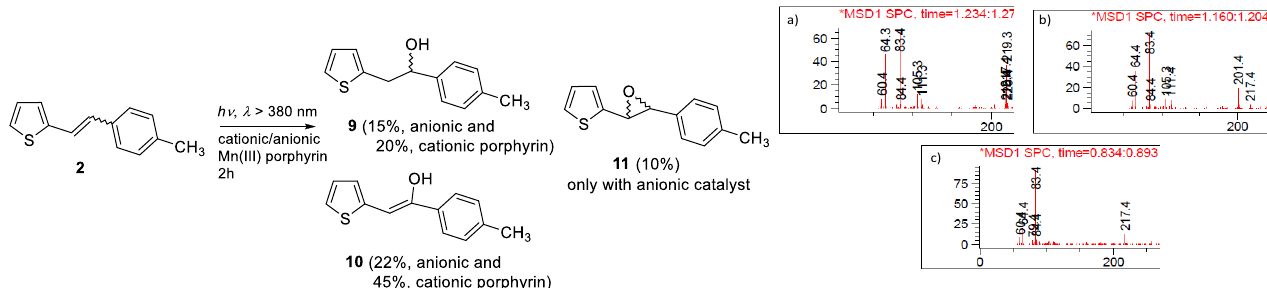
Scheme 2. Reaction pathways and product ratios for the photocatalytic oxygenation of 2 in air-saturated system at pH 7, using cationic or anionic Mn(III) porphyrins, together with mass spectra obtained on the UPLC/MS system for thienyl photooxygenation products 9 ( a ), 10 ( b ), and 11 ( c ) with the corresponding retention times.